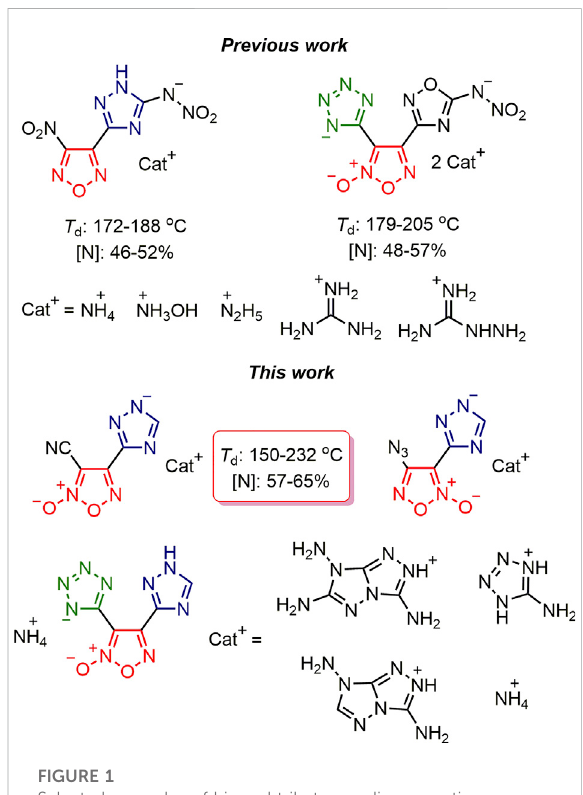
FIGURE 1 Selected examples of bi- and triheterocyclic energetic